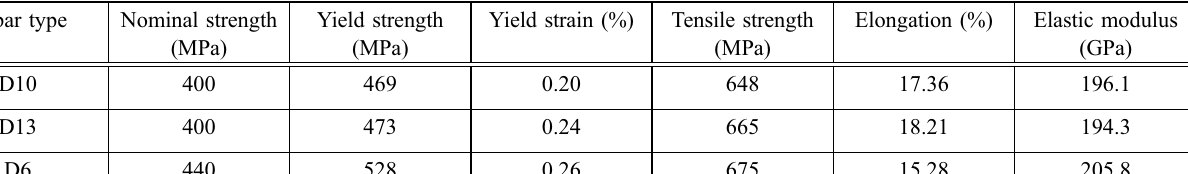
Table 3 Mechanical properties of steel reinforcement.